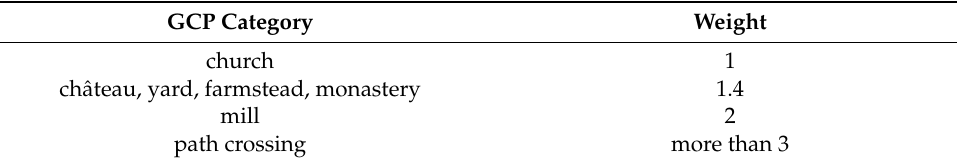
Table 2. Weight estimates of particular GCP